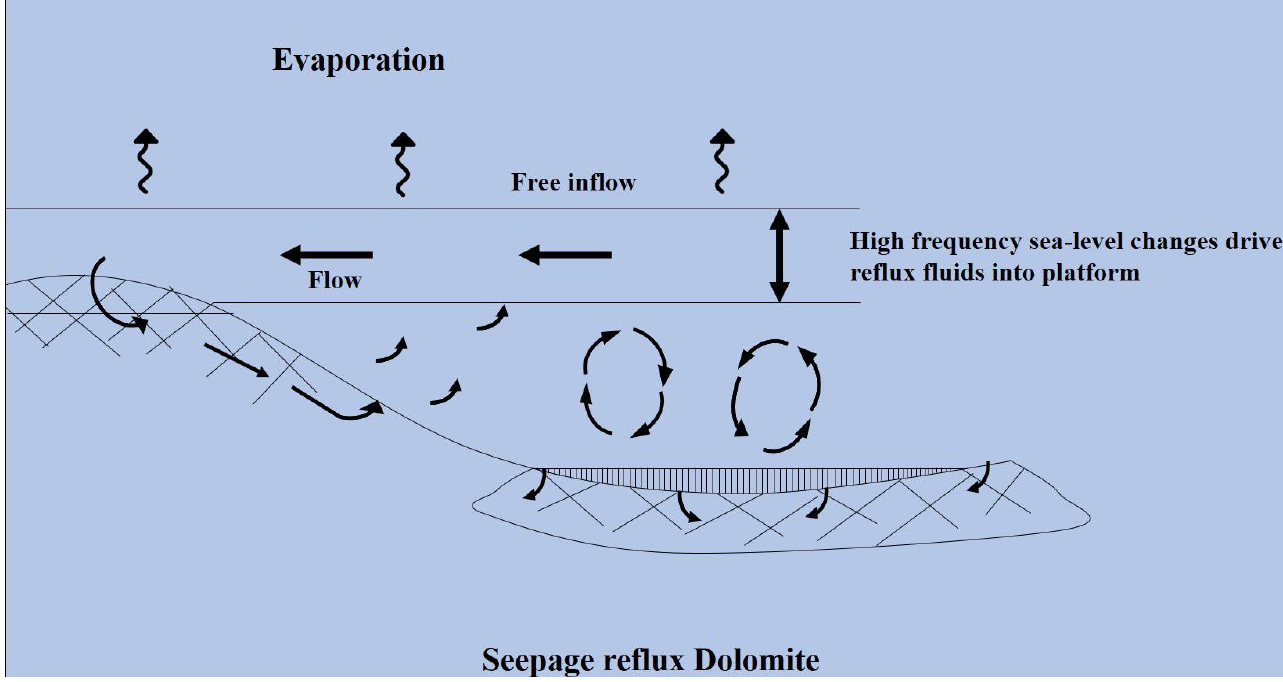
Figure 12. Mechanism of dolomitization (modified after [54,55] ).